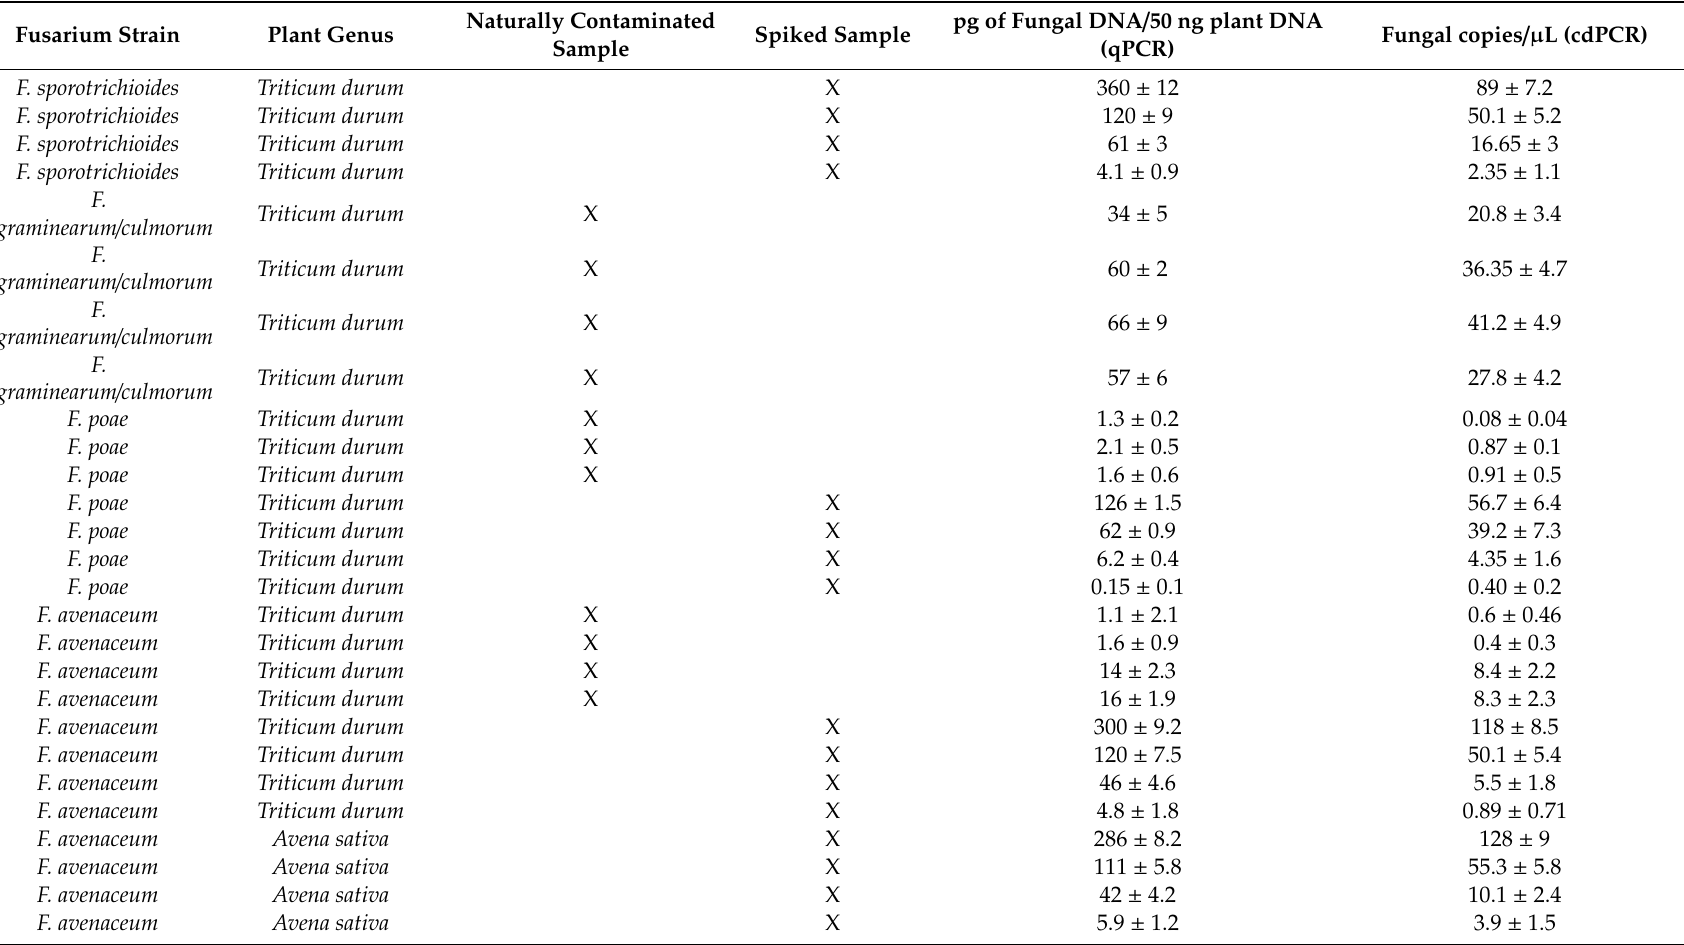
Table 5. Fusarium quantification values obtained in both naturally contaminated and in spiked samples with qPCR and cdPCR technologies. Fusarium